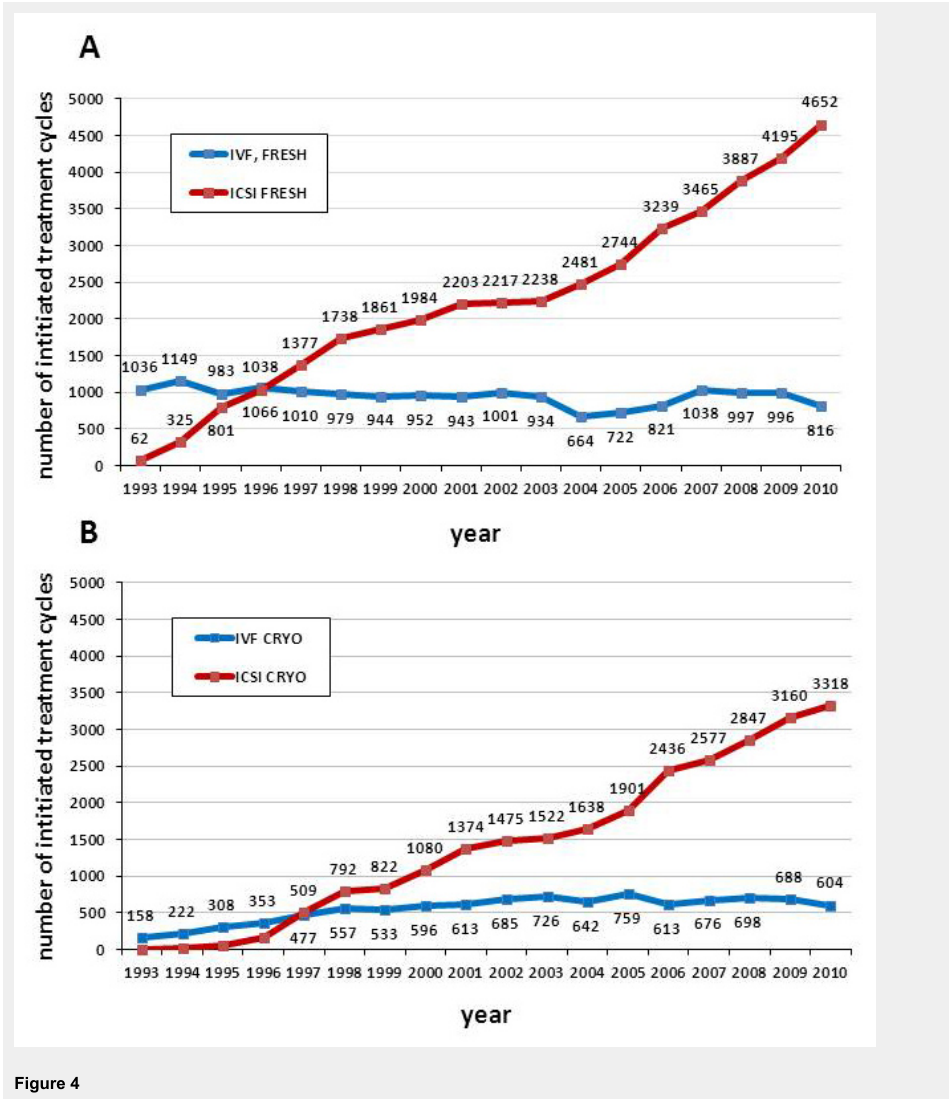
The number of treatment cycles with IVF and ICSI during freshly stimulated treatment cycles (A) and after cryopreservation and thawing (B) have been collected systematically by FIVNAT-CH since 1992 (Source: ■■■?). Whereas the number of treatments with ICSI is continuously rising, those with IVF have remained stable. As the incidental total failure of fertilisation cannot be predicted reliably, many institutions offer ICSI to all couples irrespective of the semen